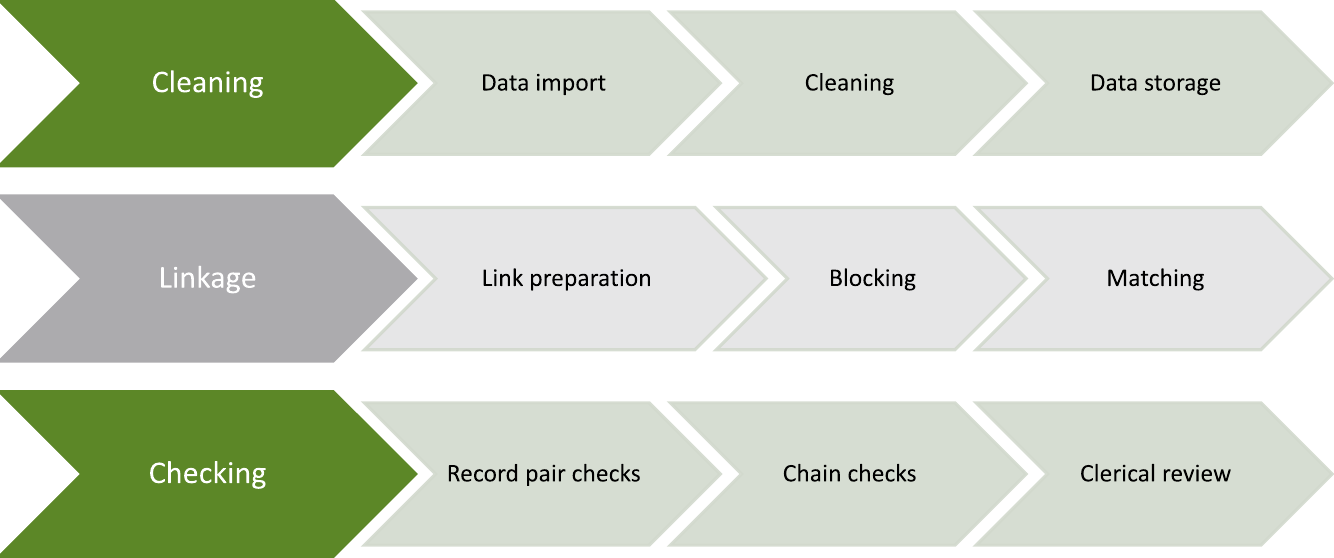
Figure 1: Diagrammatical representation of DLS3